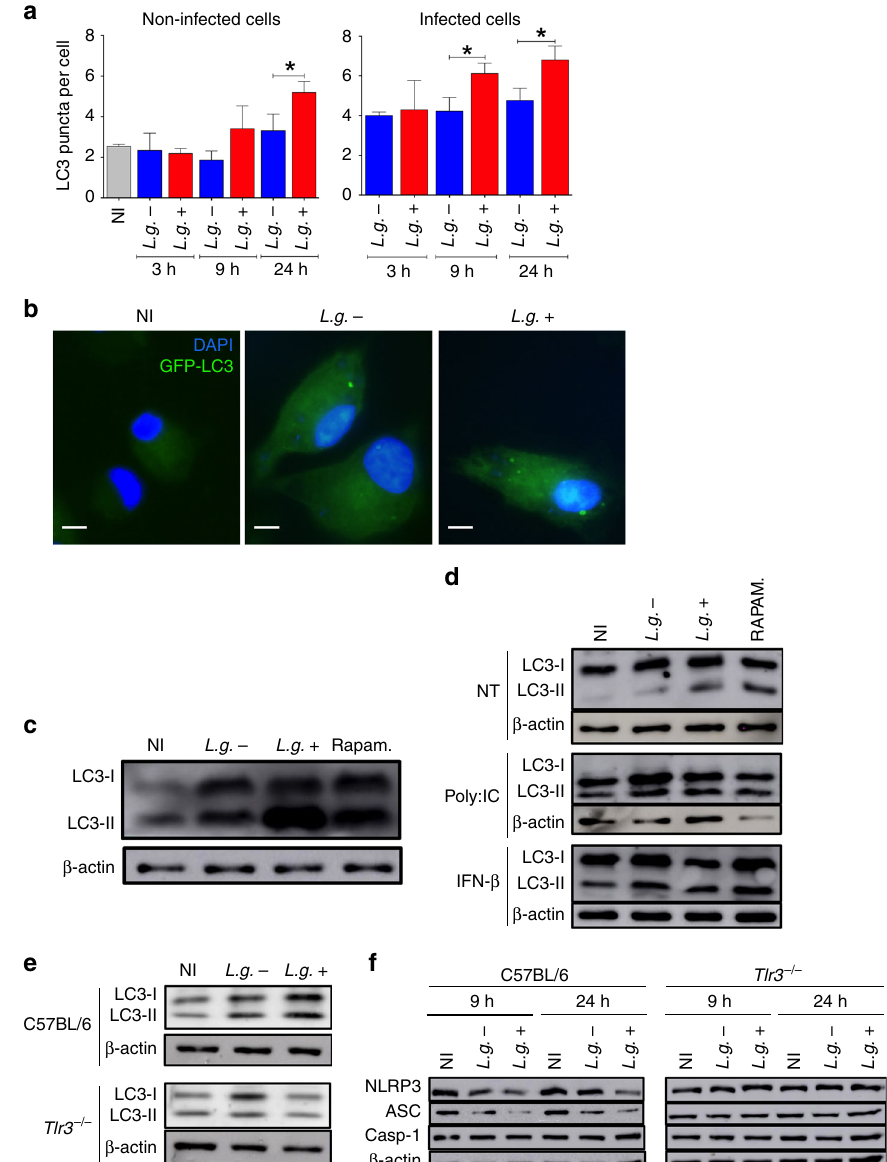
Fig. 5 LRV increases autophagy via TLR3 and degrade NLRP3 and ASC. a Immuno fl uorescence of C57BL/6 BMDMs transduced with a retroviral vector encoding LC3-GFP, left non-infected (NI) or infected with L.g. − or L.g . + for 3, 9, and 24 h. Cells were stained with DAPI (nuclei) and the average number of LC3 puncta per non-infected or infected cell was counted. b Representative fl uorescence images of non-infected (NI) or infected BMDMs for 24 h.